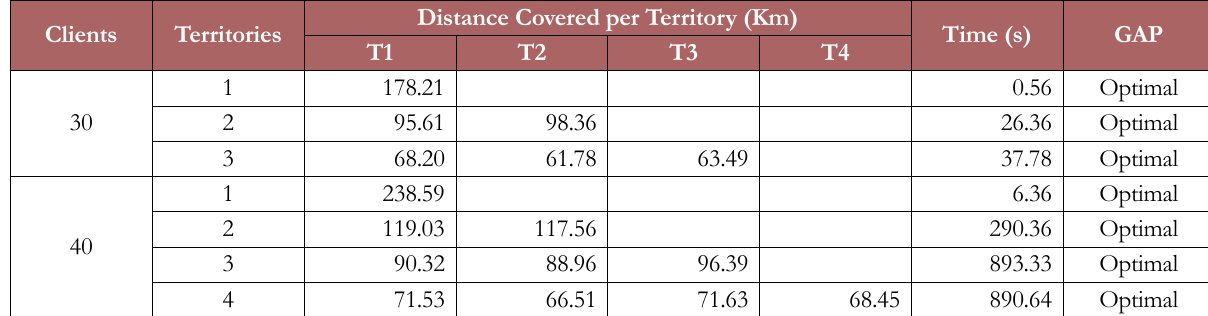
Table 1. Results with a great variation in demand